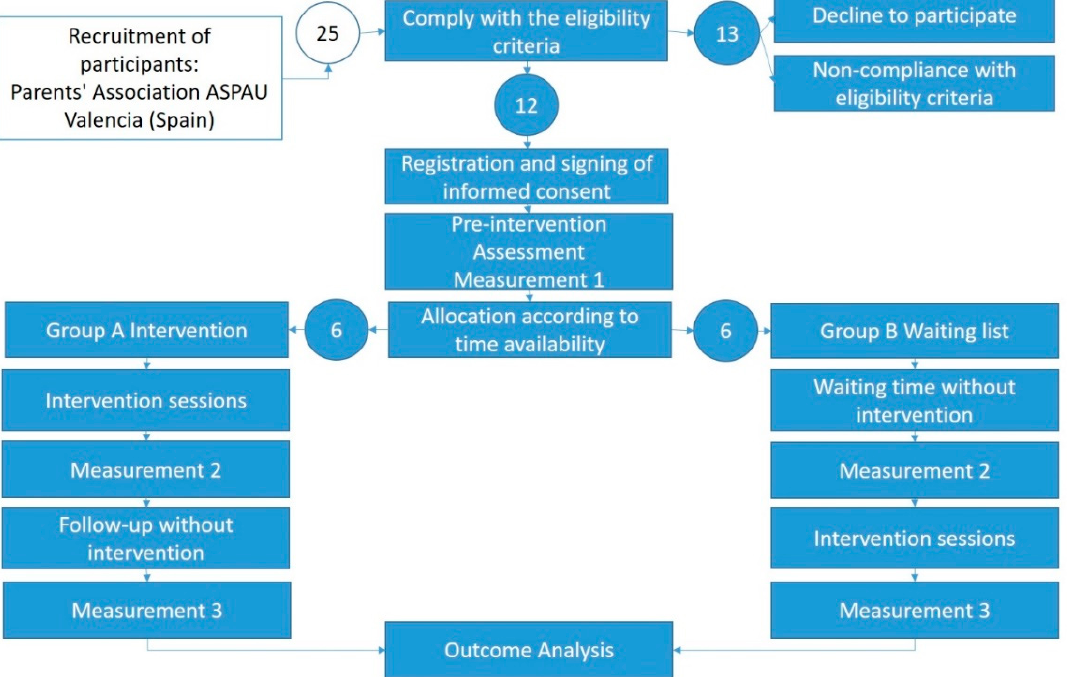
Figure 1. Distribution of the groups and description of the procedure.